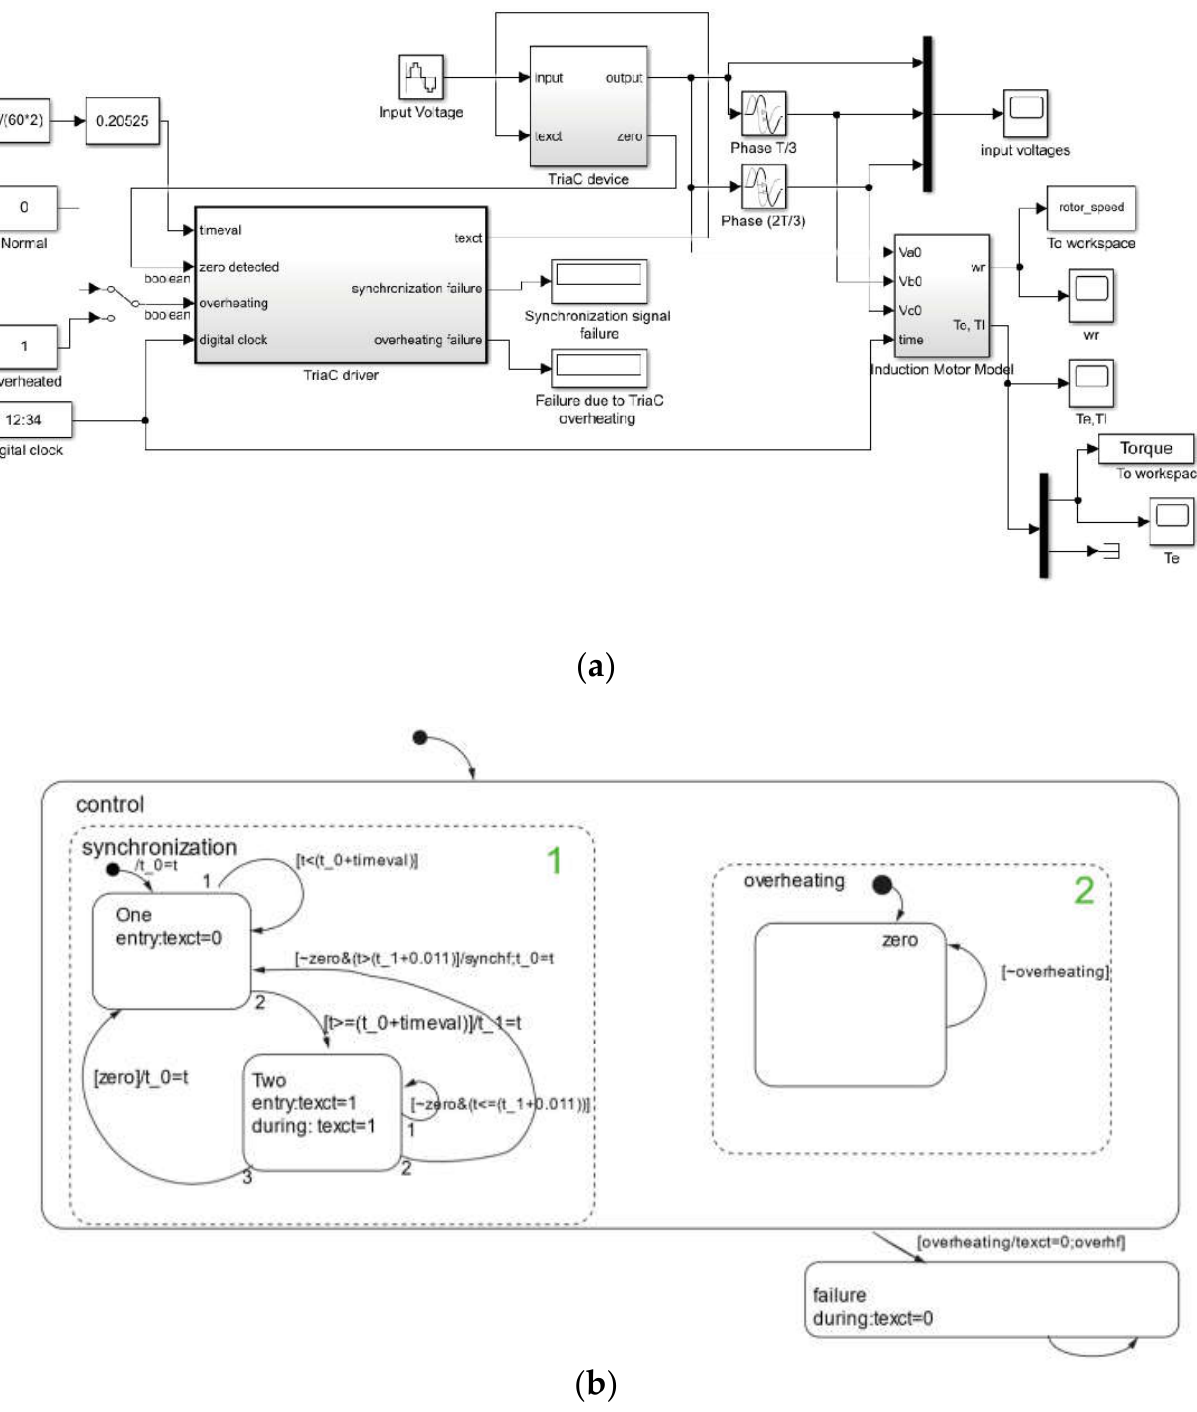
Figure 2. ( a ) Simulink-block diagram of an induction motor controlled by a TriaC device. ( b ) Zooming the TriaC driver stateflow block interior.